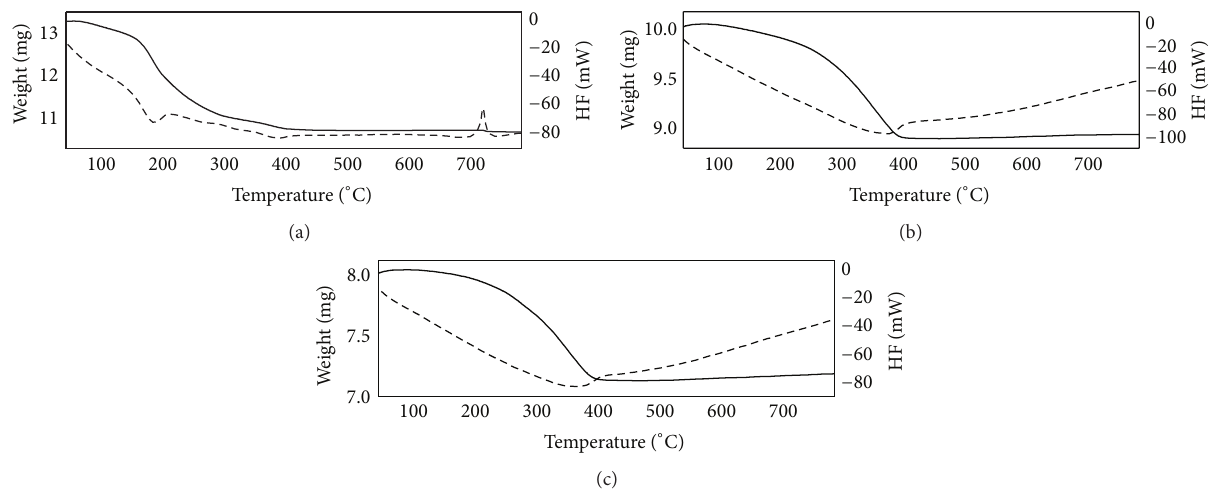
Figure 4: TGA/DTA curves of 𝛼 -GaO(OH) nanoparticles obtained in aqueous solution through hydrolysis with (a) urea, (b) NH 4 OH, and (c) NaOH.